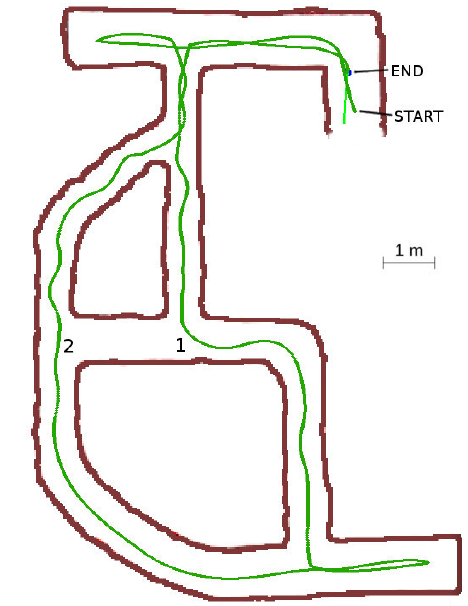
Figure 23. Cyclic labyrinth with curve